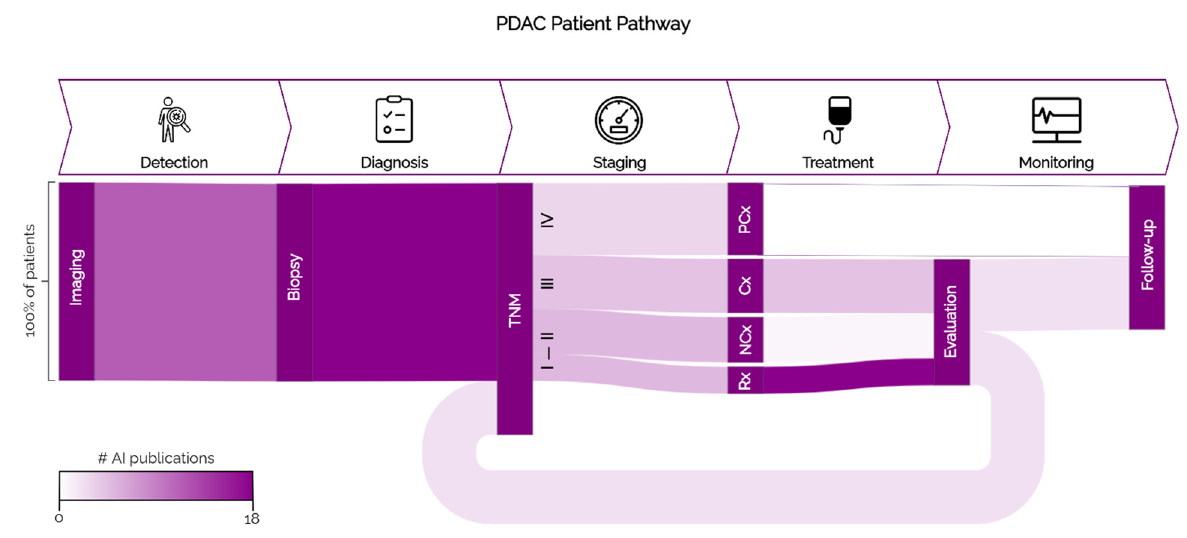
Figure 1. PDAC patient pathway. The steps of the general cancer patient pathway are shown in the top part of the figure. Below, the vertical boxes show the actions/guidelines for PDAC used in each step. The width of the streams represents the proportion of patients that go through each branch of the pathway, and the colours of the streams represent the number of AI publications found on that topic. Rx: resection; nCTx: neoadjuvant chemo(radio)therapy; aCTx: adjuvant/induction therapy; Px: palliative care.